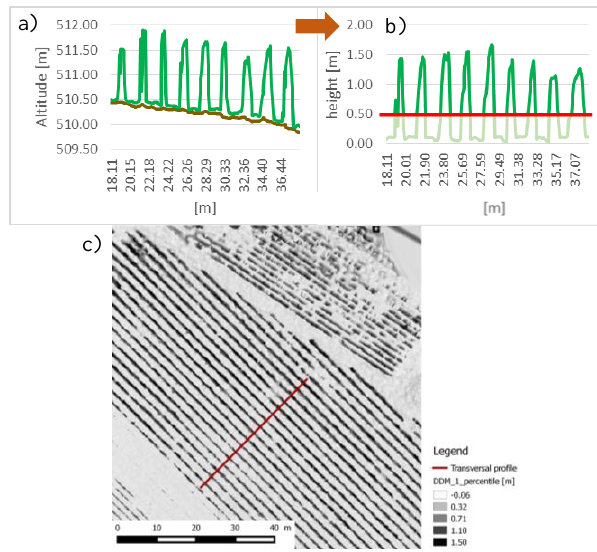
Figure 7: Process of row extraction a) DTM calculation (profile view, braun), b) selection of grape pixels, (profile view), c) visualisation of digital differential model and the transversal profile (DDM) (aerial view).